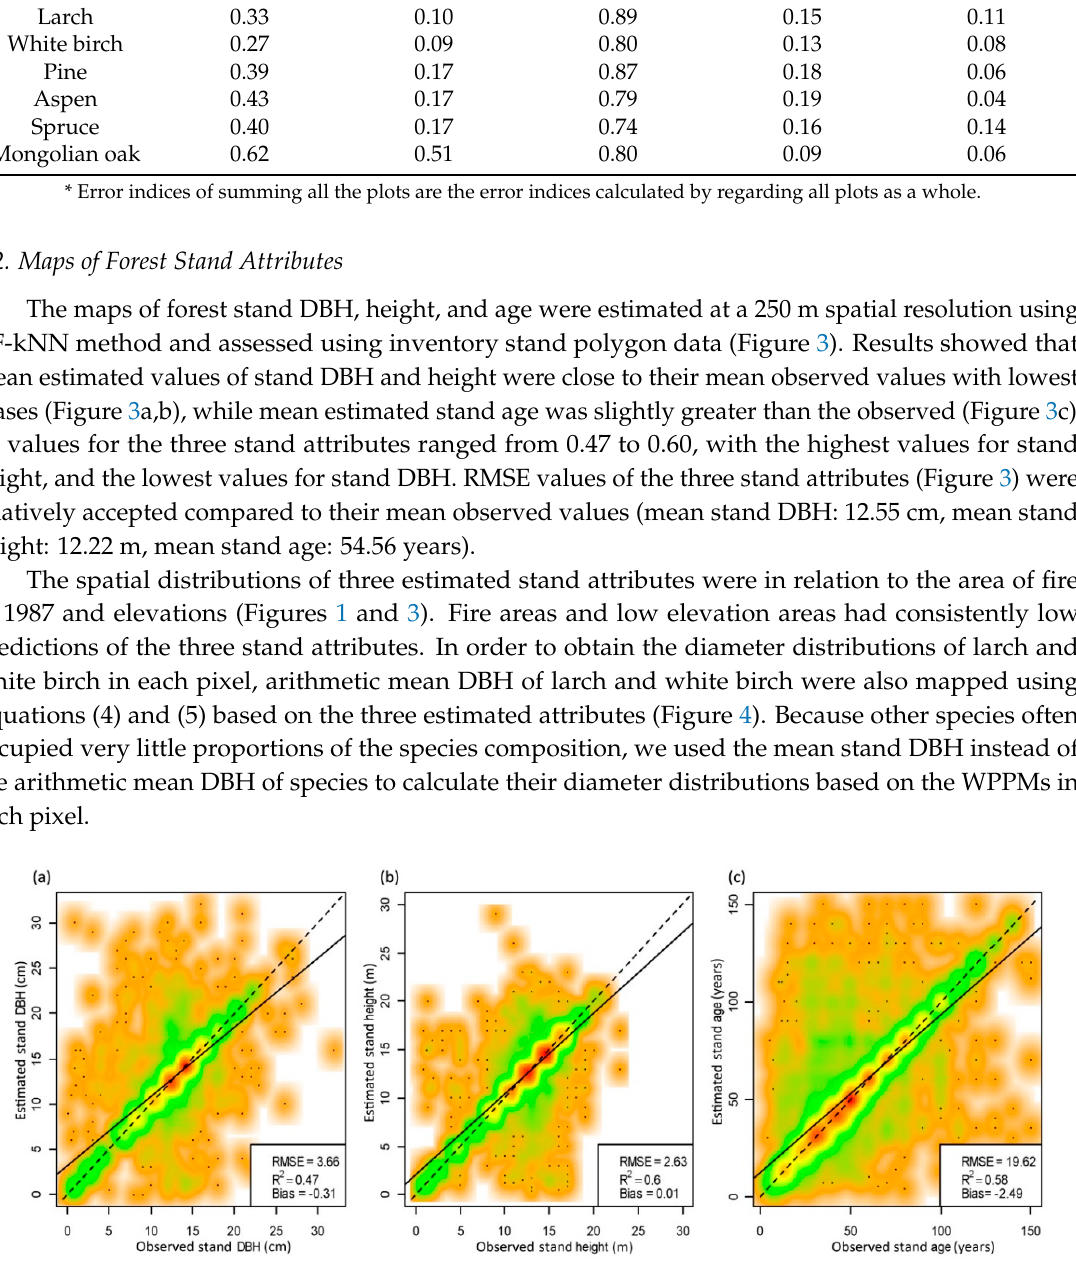
Figure 3. Goodness-of-fittings (density scatterplots) of the random forest (RF)-based kNN models of stand DBH, height, and age ( a , b , c ) and maps of estimated diameter, height, and age ( d , e , f ). The points superimposed on the density image are the points from those areas of lowest regional densities, which are the identification of outliers. The dotted line is the 1:1 line and the dashed line is the geometric mean functional regression line. Figure 4. Maps of arithmetic mean DBH of larch ( a ) and white birch ( b ) based on Equations (4) and (5). 3.3. Maps of Tree Density from Tree-Lists Tree density (trees with DBH >5 cm) of three main forest types derived from estimated tree-lists in 2000s based on WPPMs did not show noticeable difference compared to the observed tree density